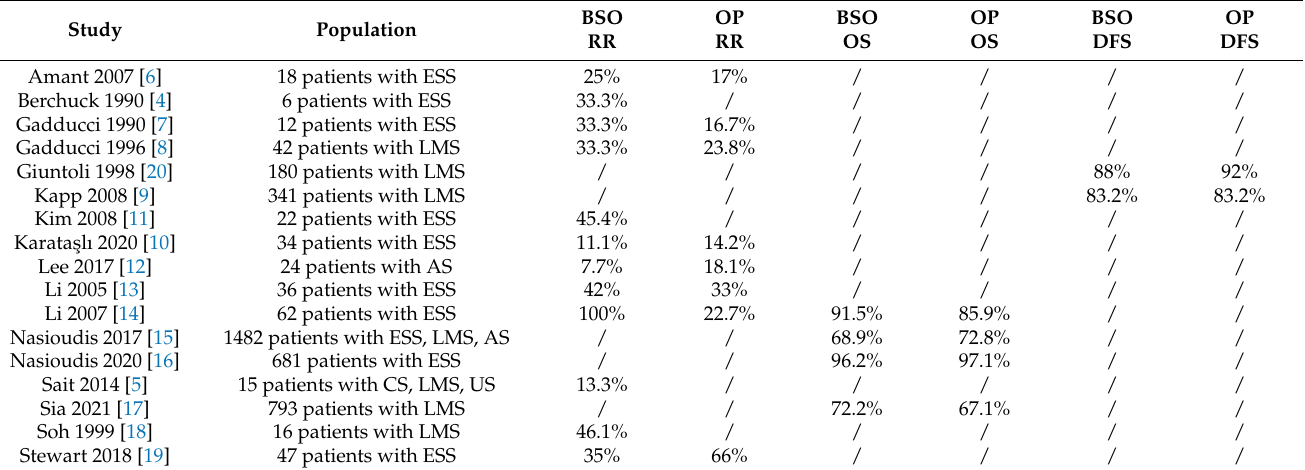
Table 2. Recurrence rate, Overall survival and Disease-Free Survival of the